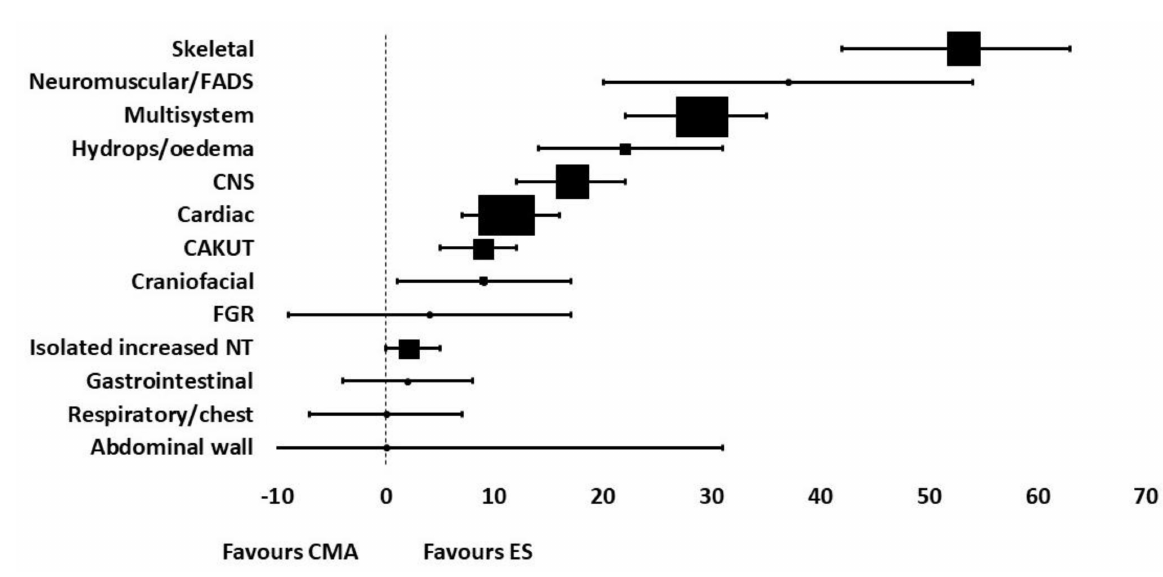
Figure 1. Forest plot summarizing the diagnostic yield of exome sequencing for abnormalities in each system, using data from the systematic review by Mellis et al.